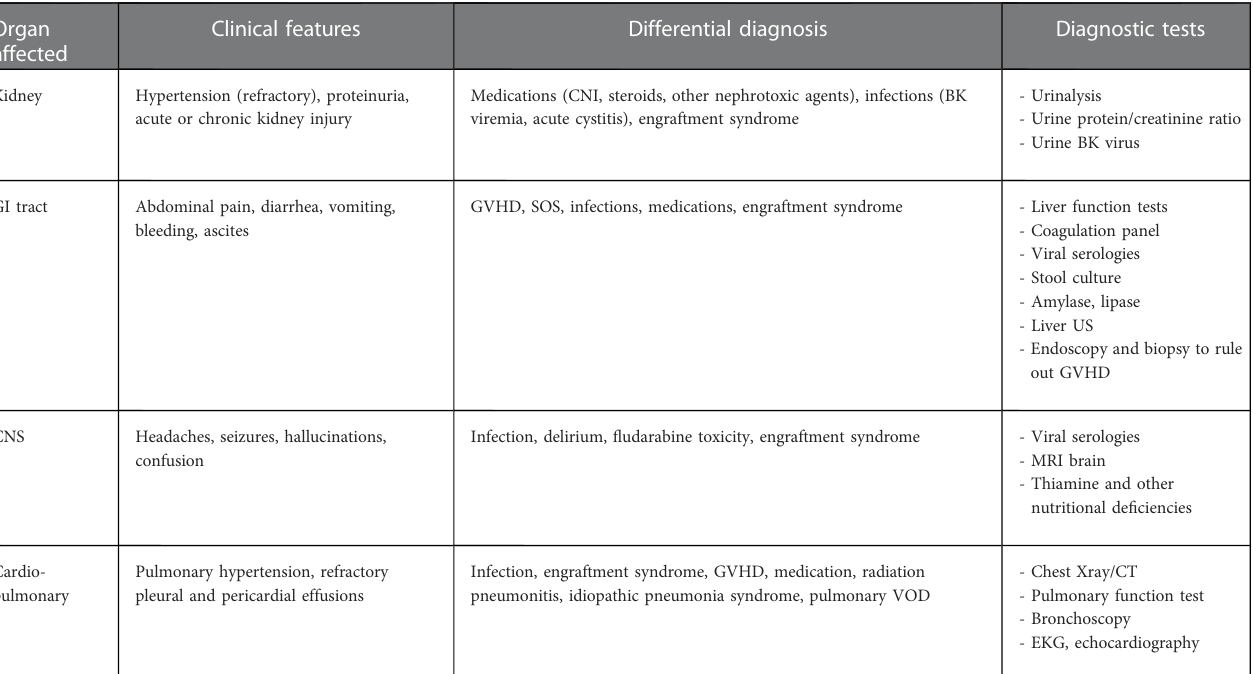
TABLE 4 Differential diagnosis of